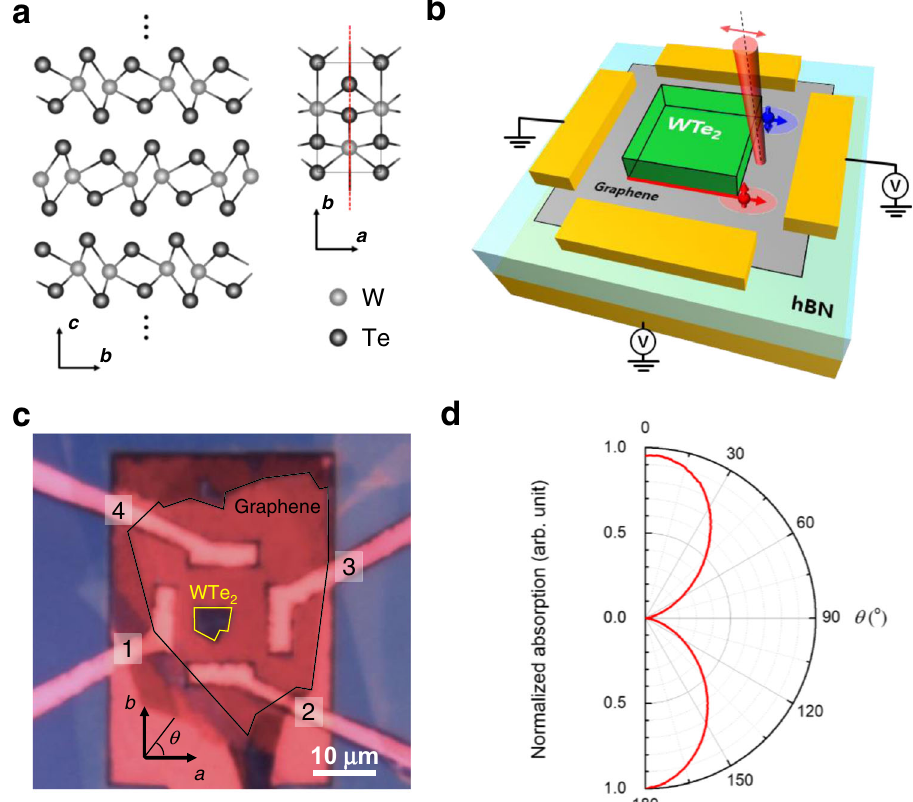
Fig.1|CrystalstructureofmultilayerTd-WTe2andexperimentaldesign.a The T d structureofmultilayerWTe 2 isnon-centrosymmetricwithamirrorplane dashed line). b Schematic experimental design for detecting the spin-polarized electronic states in WTe 2 . The electrical bias voltagemakes electrons fl ow through WTe 2 , while the spin polarization of the electrons is optically recorded as the Kerr rotation induced in the linearly polarized pump (980nm, 1,415W/cm 2 ). The pump laser with a spot size of 1.5 μ m sweeps through a 6 μ m × 10 μ m region at graphene